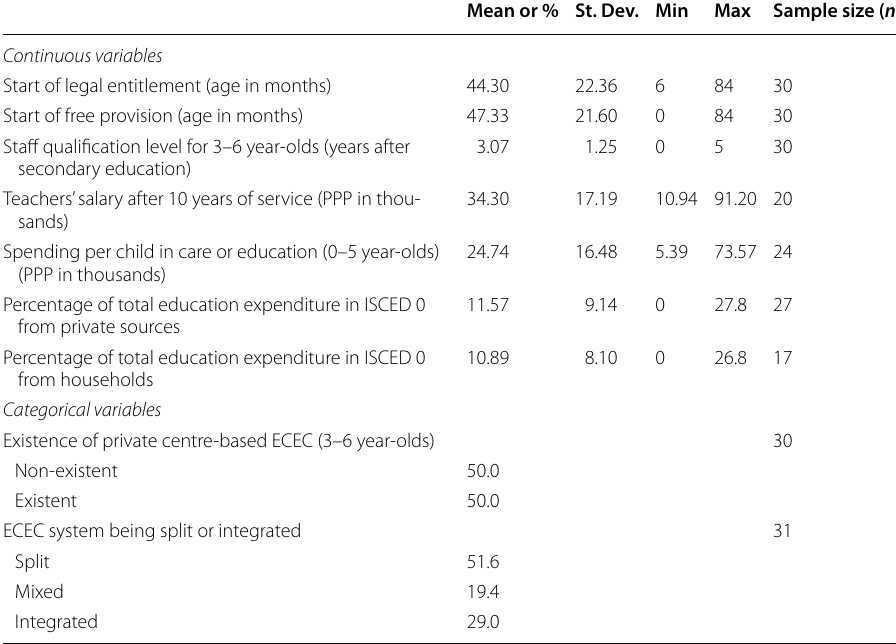
Table 2 Descriptive statistics of independent variables